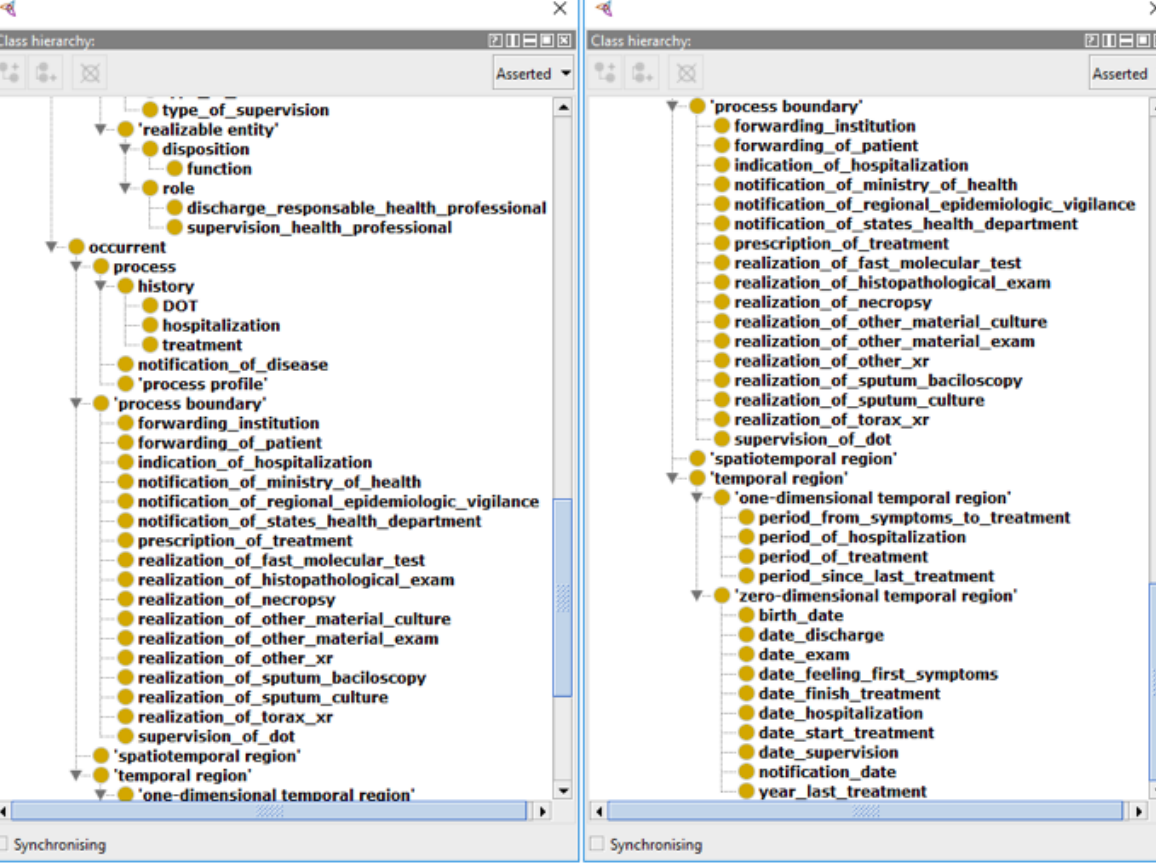
Figure 4. Second part of the tuberculosis entities mapped into the Basic Formal Ontology